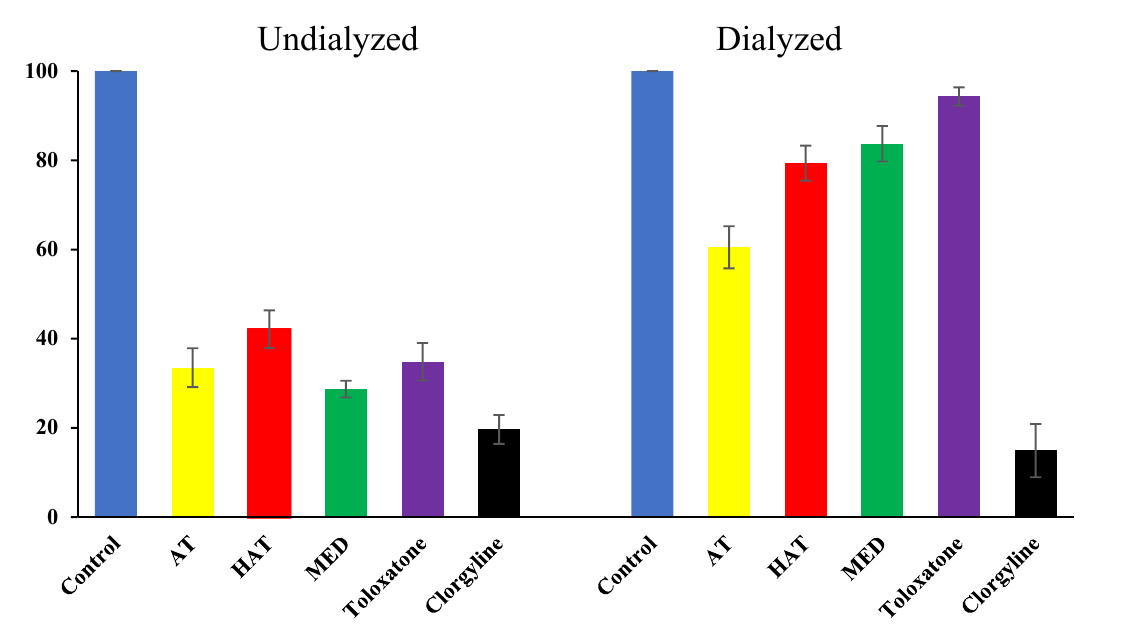
Figure 4. Recovery of hMAO-A inhibition by AT, HAT, and MED through dialysis. The concentrations of inhibitors used in the experiment were ~ 2 × IC 50 values. AT, 0.040 µ M; HAT, 0.60 µ M; MED, 18.0 µ M; toloxatone 2.0 µ M; clorgyline 0.014 µ M. Toloxatone and clorgyline were used as references for reversible and irreversible inhibitors of hMAO-A, respectively.